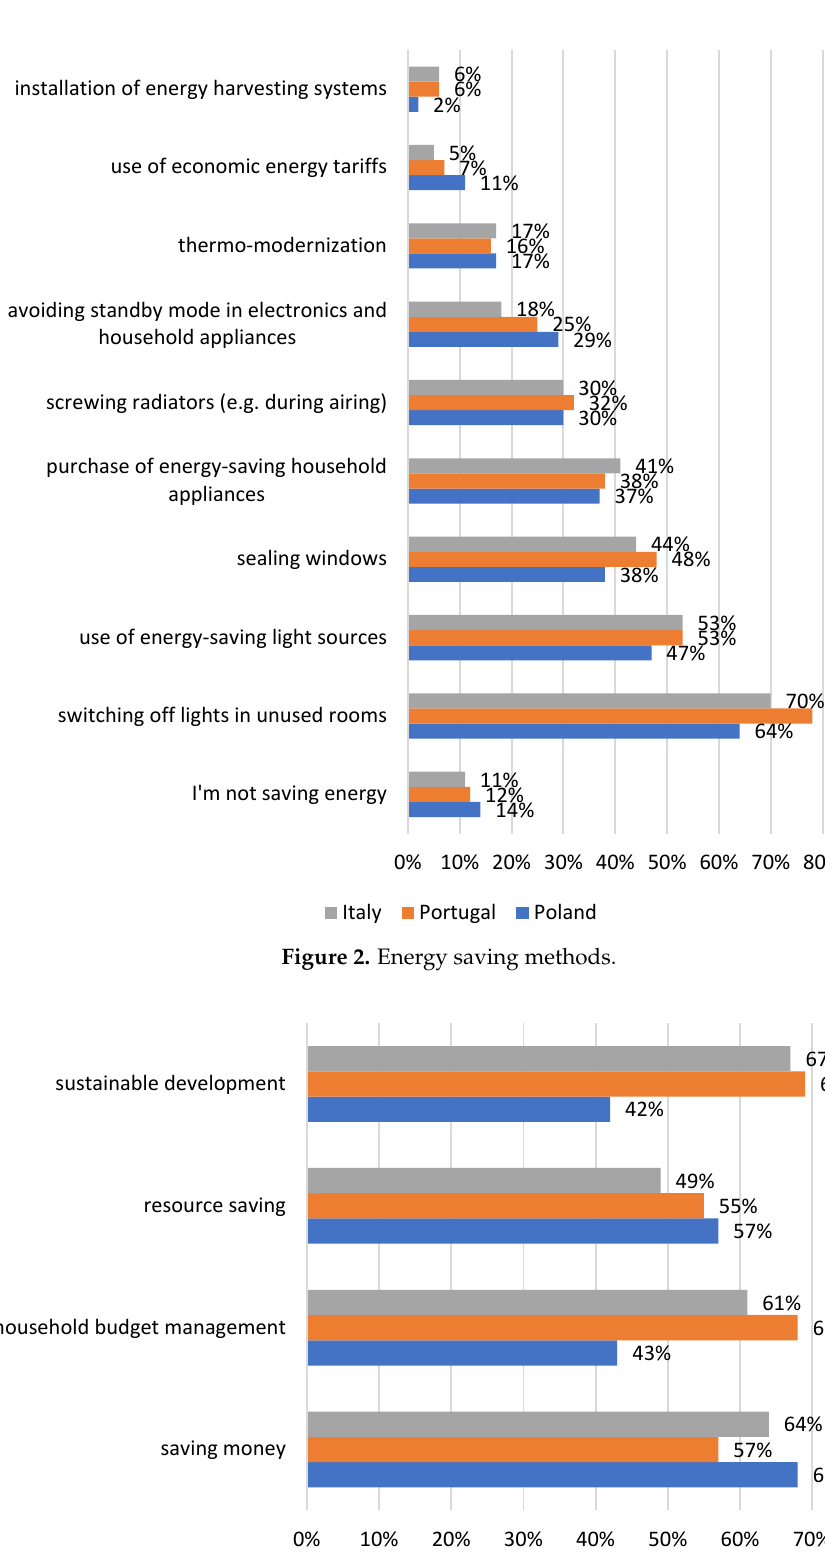
Figure 3. Reasons for saving energy.